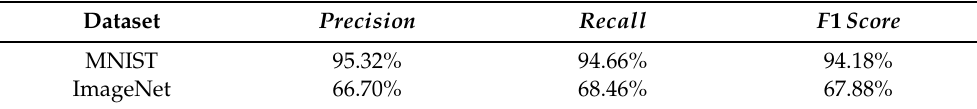
Table 4. Fidelity evaluation of two sets of watermarked